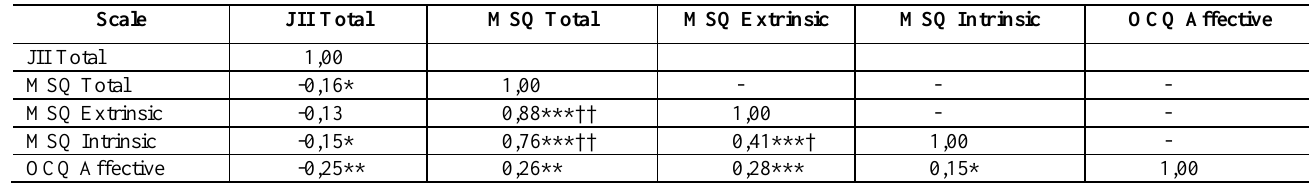
Table 2: Pearson correlation coefficients between job insecurity (JII), job satisfaction (MSQ) and affective organisational commitment (OCQ)